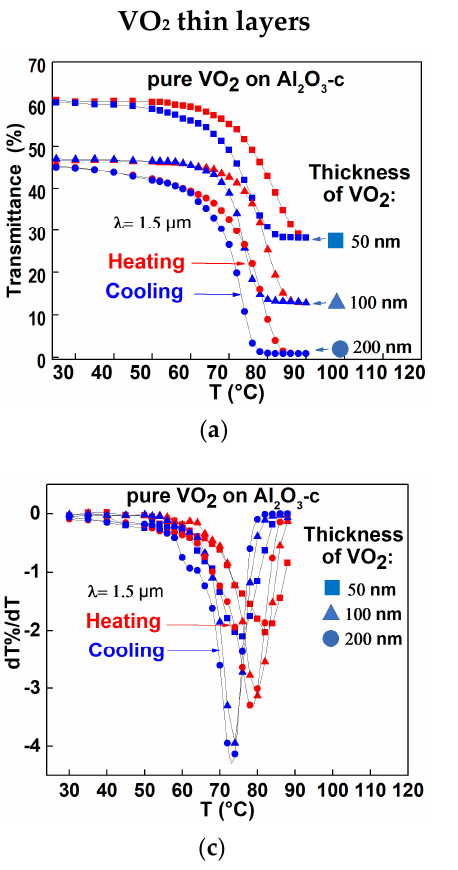
Figure 5. Optical characteristics of VO 2 –Ir microtriangles composites vs. VO 2 thin films on Al 2 O 3 -c substrate: Temperature dependence of the light transmittance of ( a ) 50, 100 and 200 nm pure VO 2 thin films; ( b ) composites made with 0.45 µm Ir microtriangles in 50, 100 and 200 nm VO 2 matrix; ( c ) Temperature dependence of the first derivative of transmittance of VO 2 thin films extracted from (a); ( d ) Temperature dependence of the first derivative of transmittance of composite made with 0.45 µm Ir microtriangles, extracted from (b).